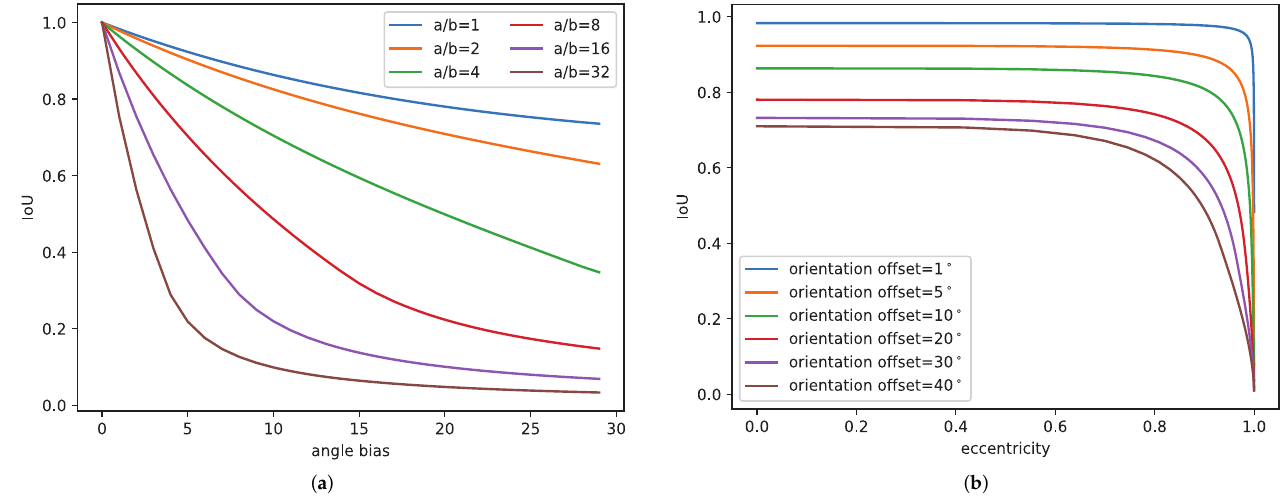
Figure 5. ( a ) IoU curves under different height–width ratios and angle biases. a/b represent the height–width ratio, i.e., the aspect ratio of the object. ( b ) IoU curves under different orientation offsets and RIE